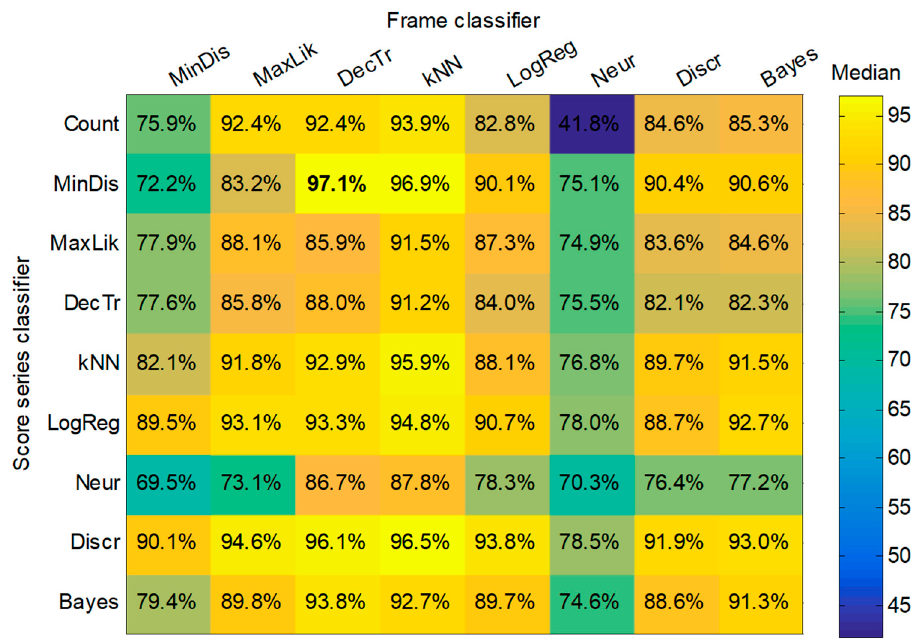
Figure 20. Matrix of the median value of performance metrics for every pair (score, frame) classifier.